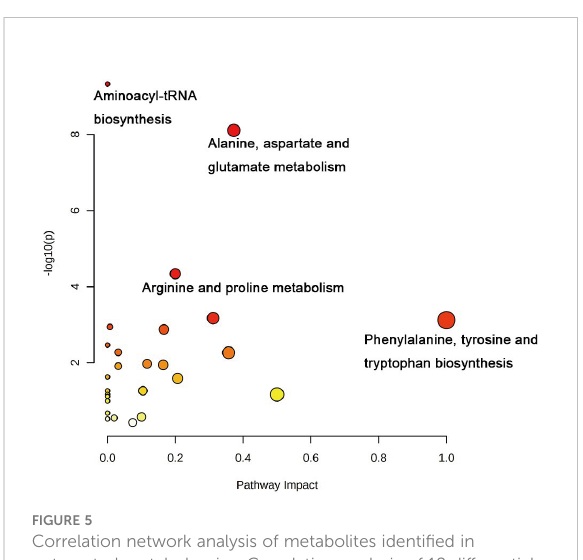
FIGURE 5 Correlation network analysis of metabolites identi fi ed in untargeted metabolomics. Correlation analysis of 18 differential metabolites with statistical differences between 1 mm surgical margin and cancerous